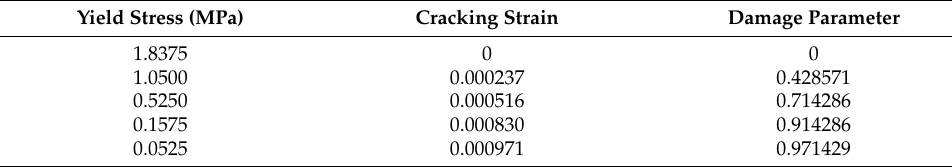
Table 6. Tensile input parameters of PCM.